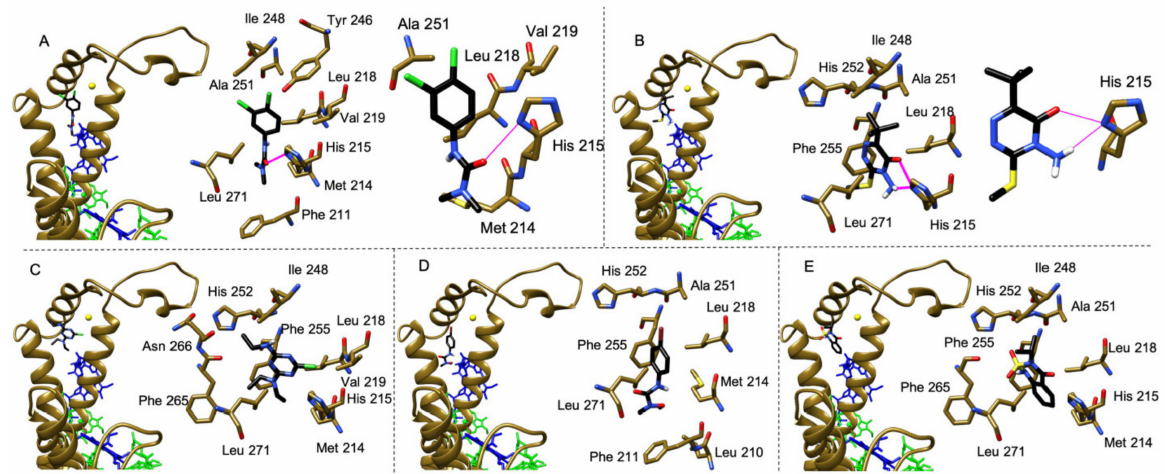
Figure 3. Molecular docking analysis of the interaction between the selected herbicides and the Q B binding site of the D1 protein (chain A, PDB: 5XNL). Binding geometry of diuron ( A ), metribuzin ( B ), terbuthylazine ( C ), metobromuron ( D ) and bentazon ( E ). In panels ( A – E ), on the left view of the herbicides in the Q B binding pocket followed by an enlarged view of the same region showing the amino acids in close contact (<4 Å) to each herbicide. In panels ( A , B ), on the right enlarged views of the same Q B binding pocket region with a different orientation to show details of the hydrogen bonds formed by the herbicides diuron ( A ) and metribuzin ( B ) with His215. The herbicide molecules are colored in black, the D1 protein and cofactors are colored as in Figure 1B,C, hydrogen bonds are indicated as purple